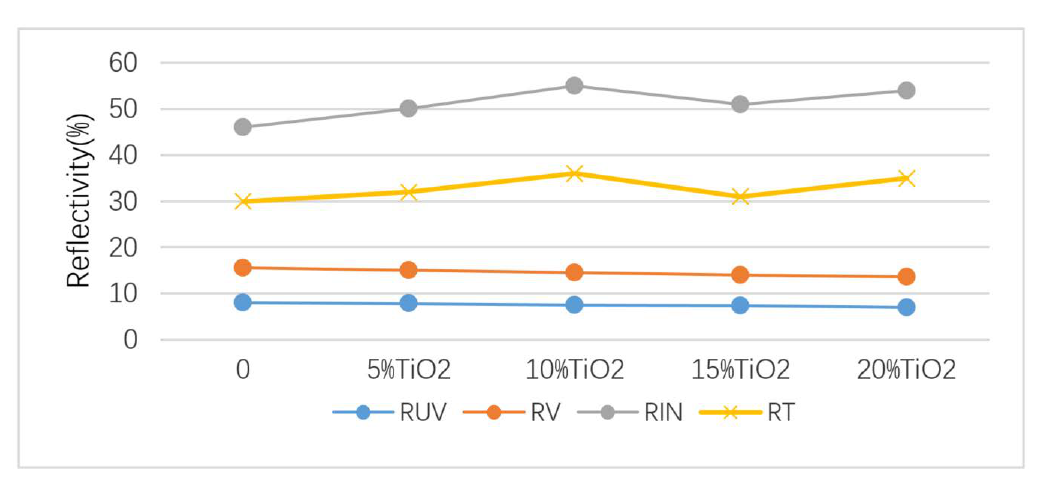
Figure 4. E ff ect of near infrared NIR-TiO 2 on the reflectivity of the coating in di ff erent